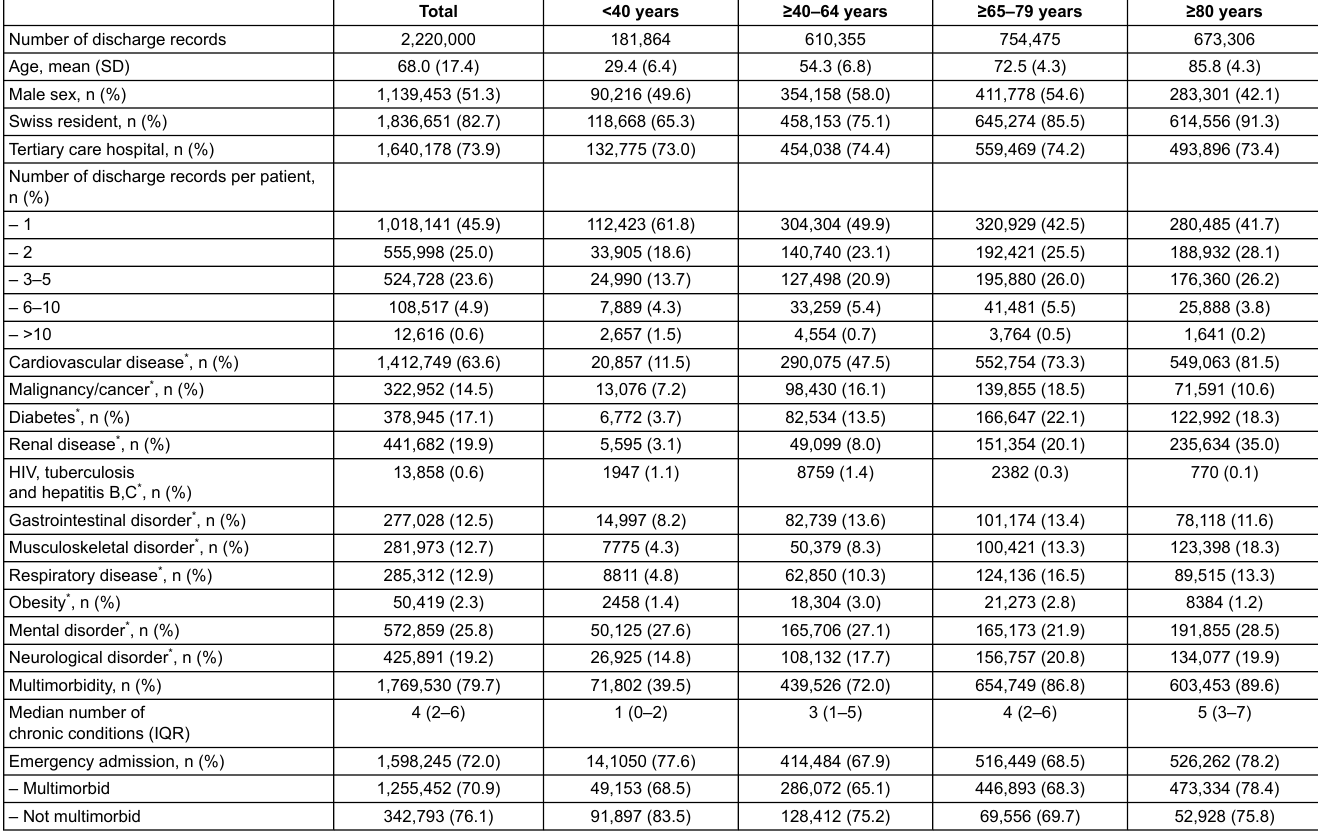
Table 1: Characteristics of medical inpatient discharge